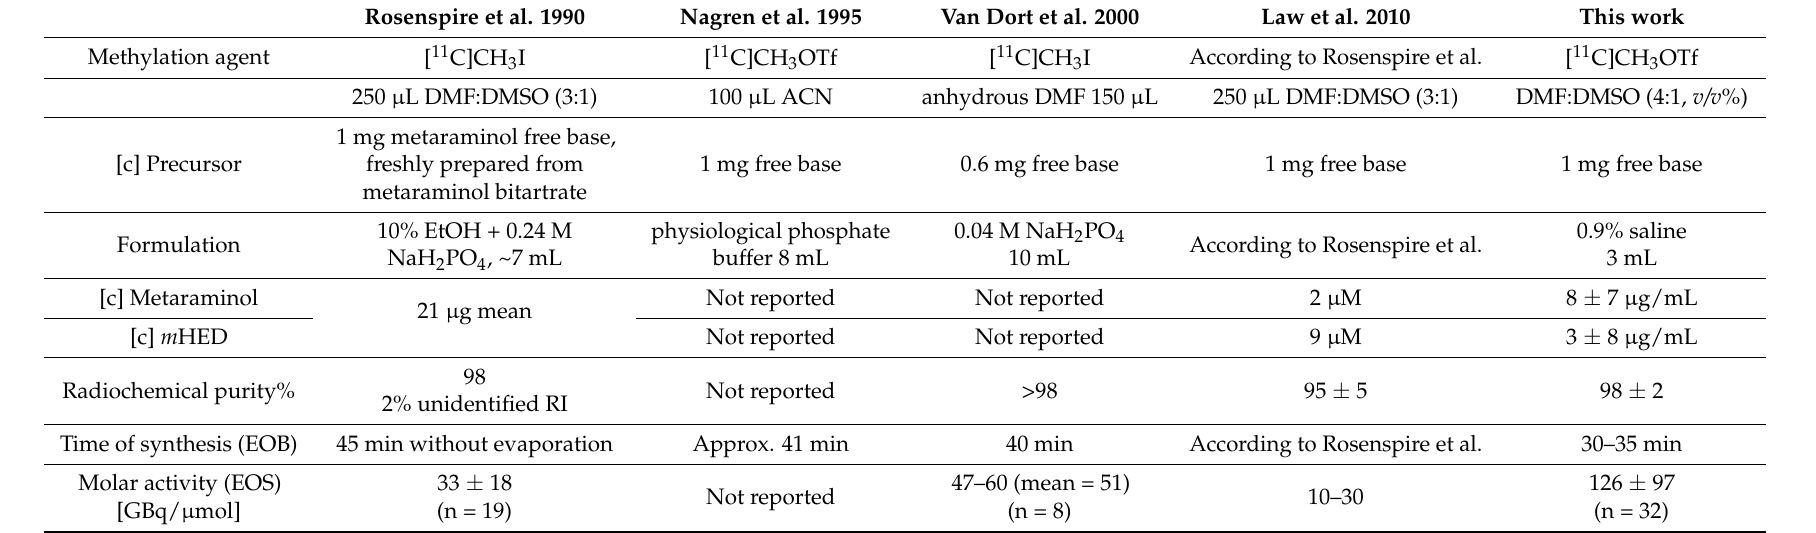
Table 3. Comparison of radiosynthetic parameters of previously published and our optimized [ 11 C] m HED